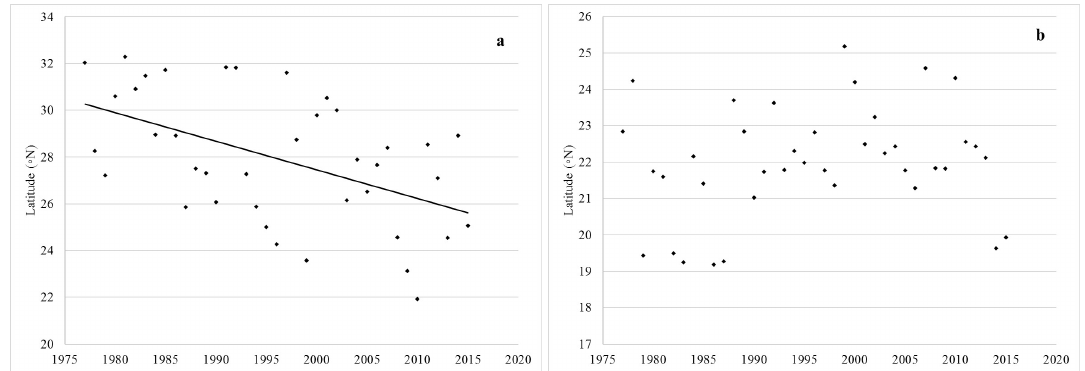
Figure 3. Mean annual LMI latitude in the ( a ) North Atlantic and ( b ) West Pacific basins. The significant linear trend of LMI latitude in the North Atlantic is shown with the solid